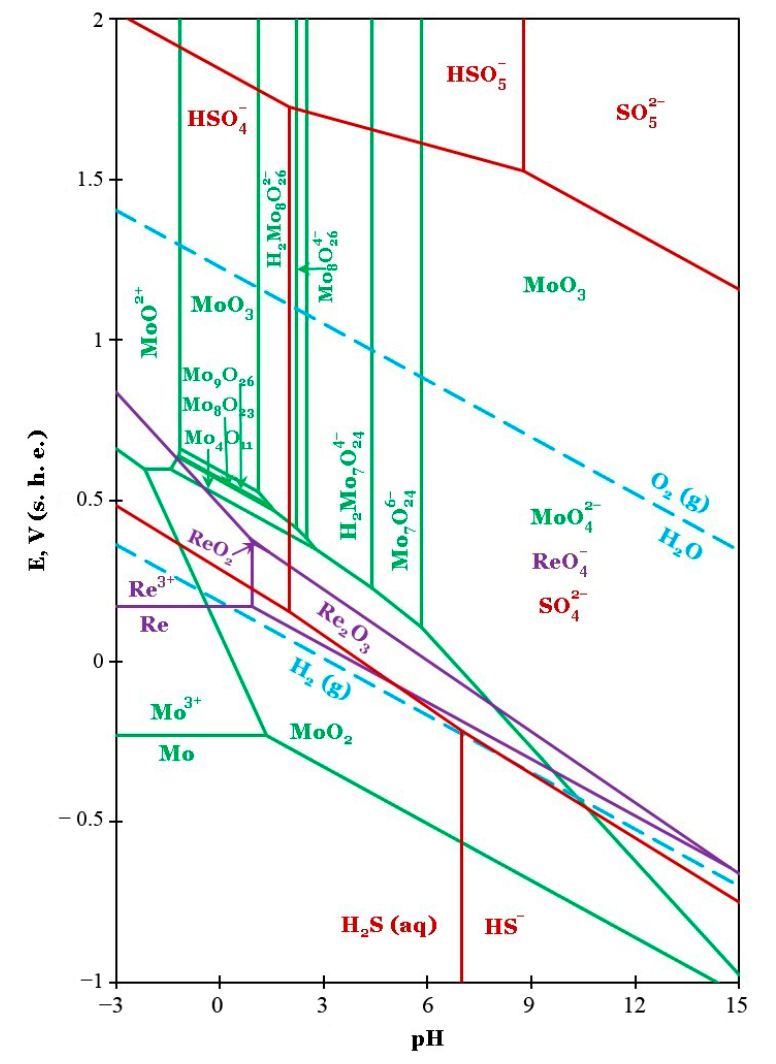
− 2 − SO –H –H 2 O system is plotted at 25 ◦ C, air pressure 4 2 O system is plotted at 25 °C, air pressure 4